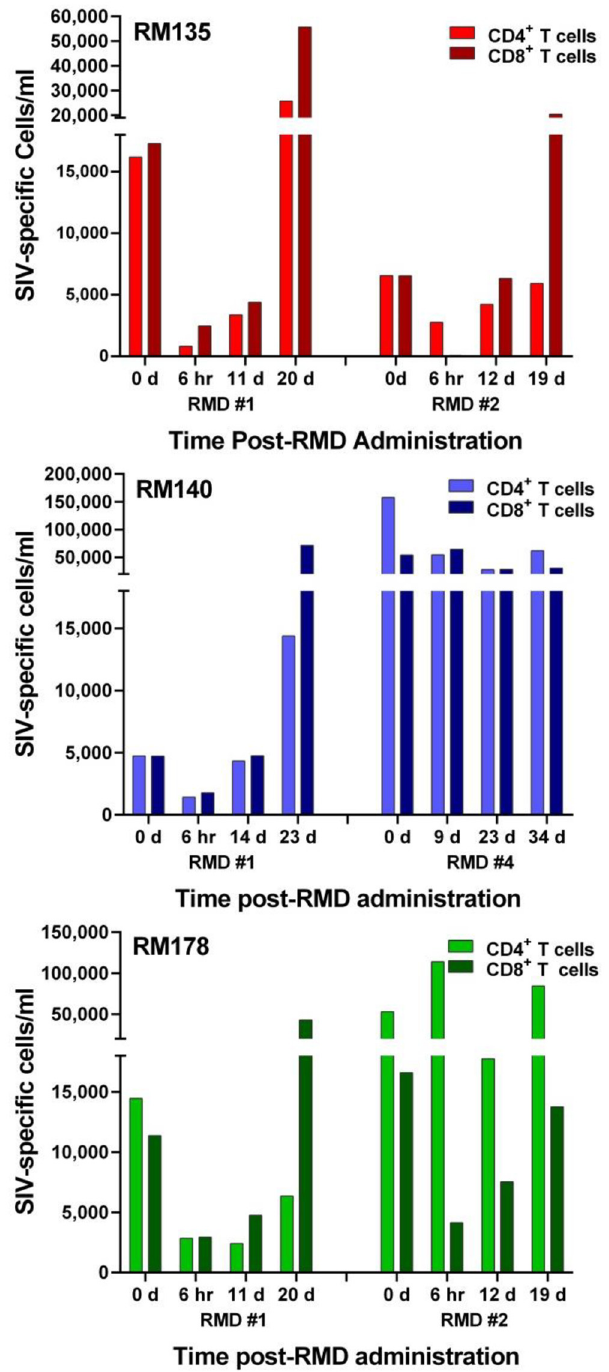
Fig 10. RMD administration does not significantly ablate the overall SIV-specific T cell responses in SIVsmmFTq post-treatment controller RMs. Absolute numbers (/ml) of the aggregated Gag- and Env- specific CD4 + and CD8 + T cells are shown at different time points following different rounds of RMD administration, as determined by intracellular cytokine staining and flow cytometry. On the X axis, the numbers represent days post-RMD